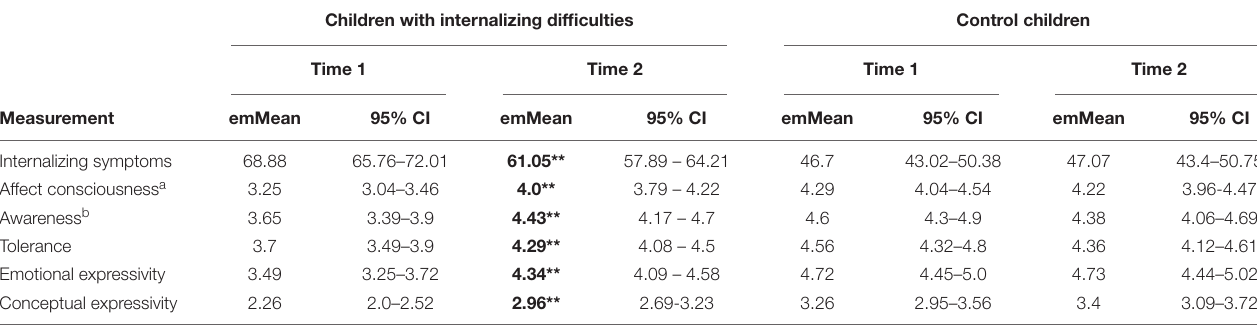
TABLE 2 | Estimated marginal means and 95% confidence intervals of internalizing symptoms and affect integration at time 1 and 2.